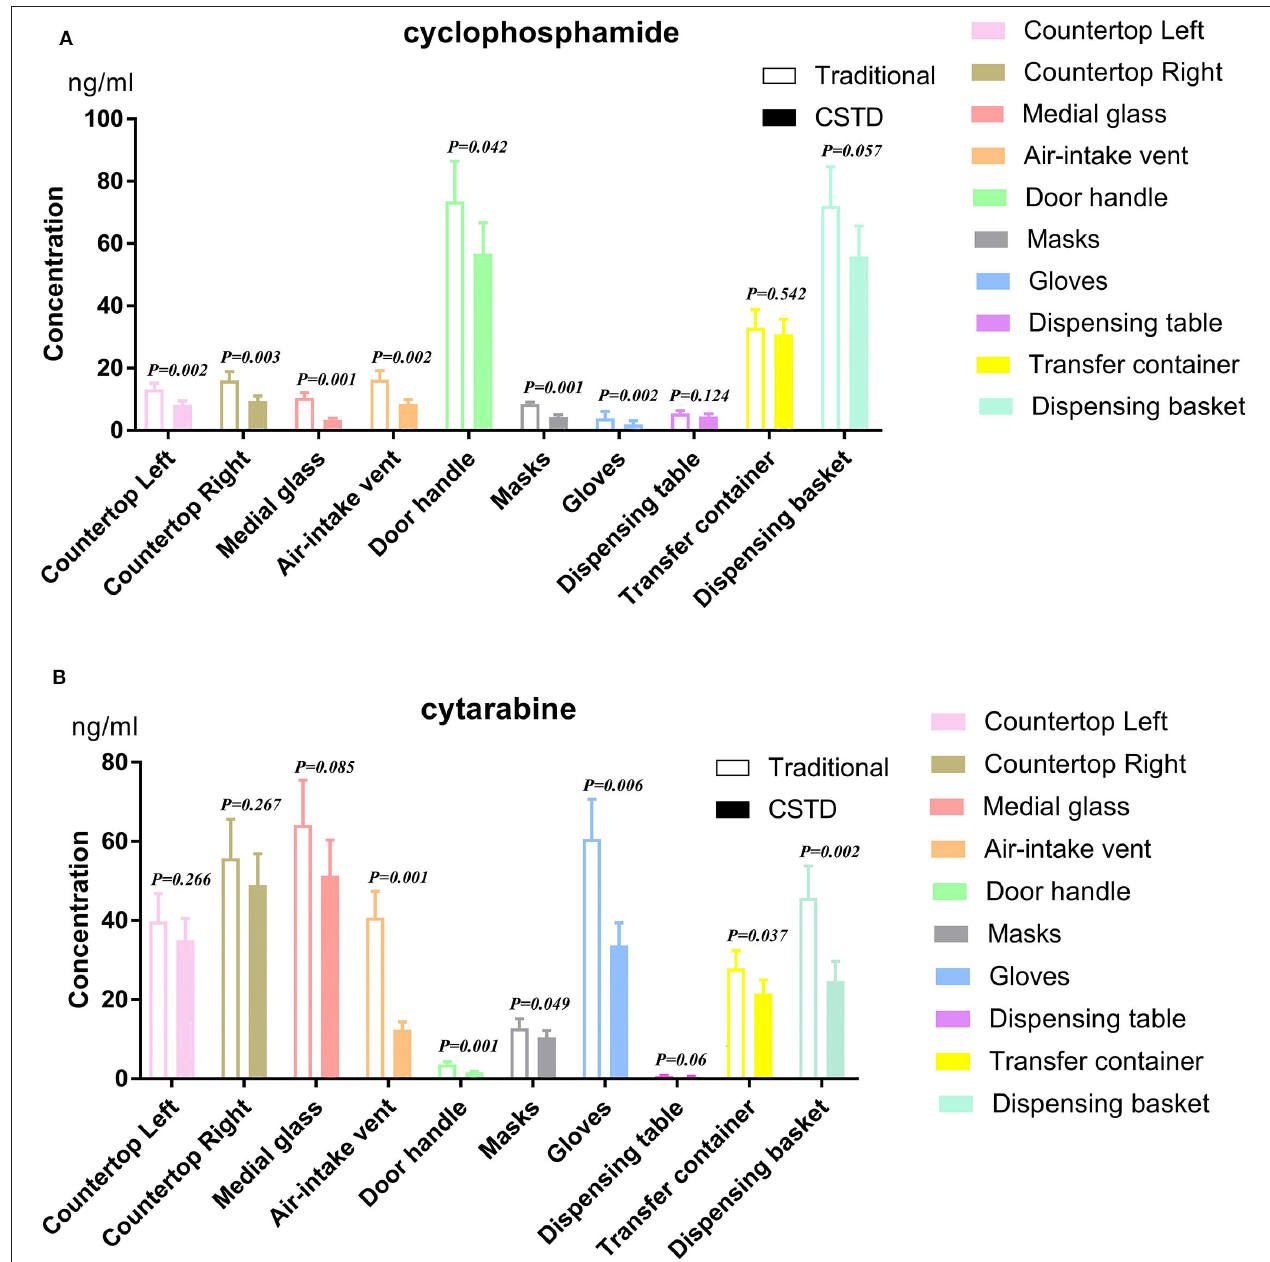
FIGURE 4 | Cyclophosphamide and cytarabine on isolator surfaces and preparation with traditional and CSTD intervention. p < 0.05 was regarded as a significant difference. (A) cyclophosphamide, (B) cytarabine.